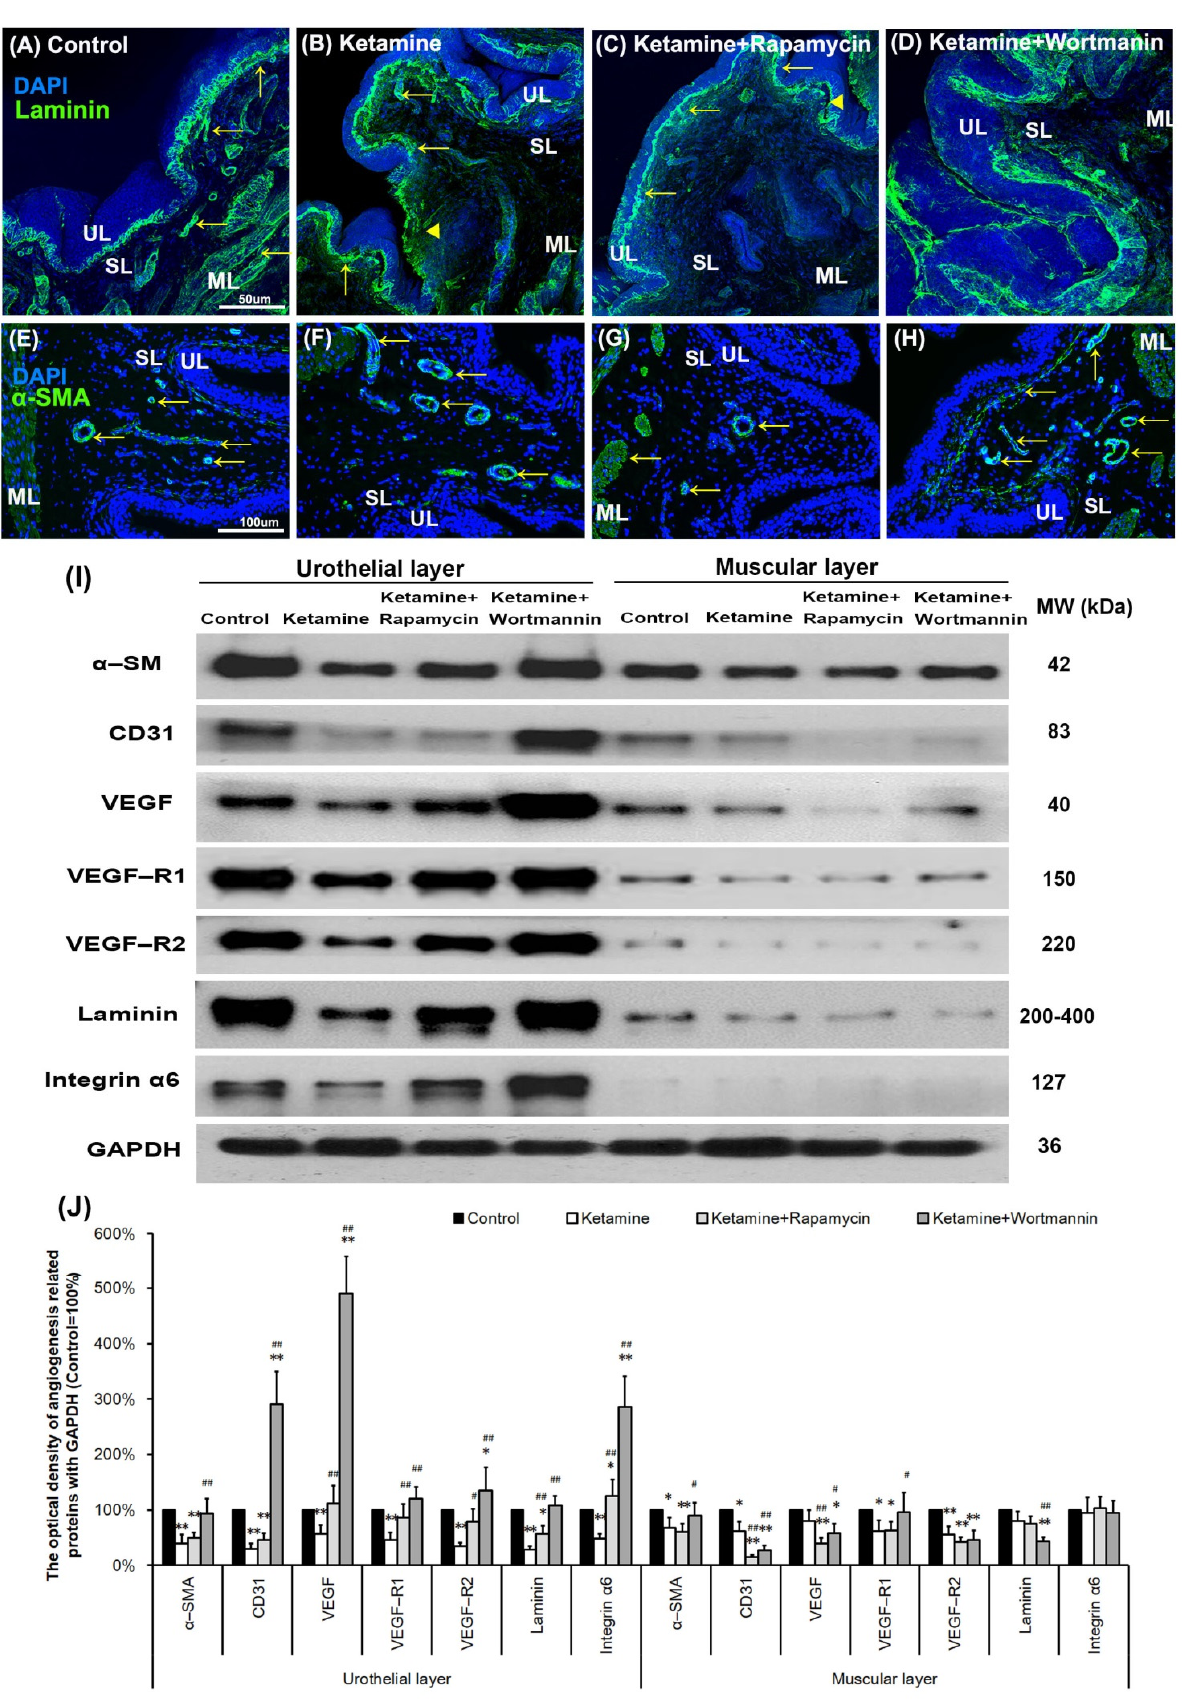
Figure 6. Autophagy altered bladder angiogenesis in the pathogenesis of KIC. ( A – H ) Immunofluorescence analysis of laminin, and α -SMA ( E – H ) (angiogenesis marker, arrows) expression after treatment with saline ( A , E ), ketamine ( B , F